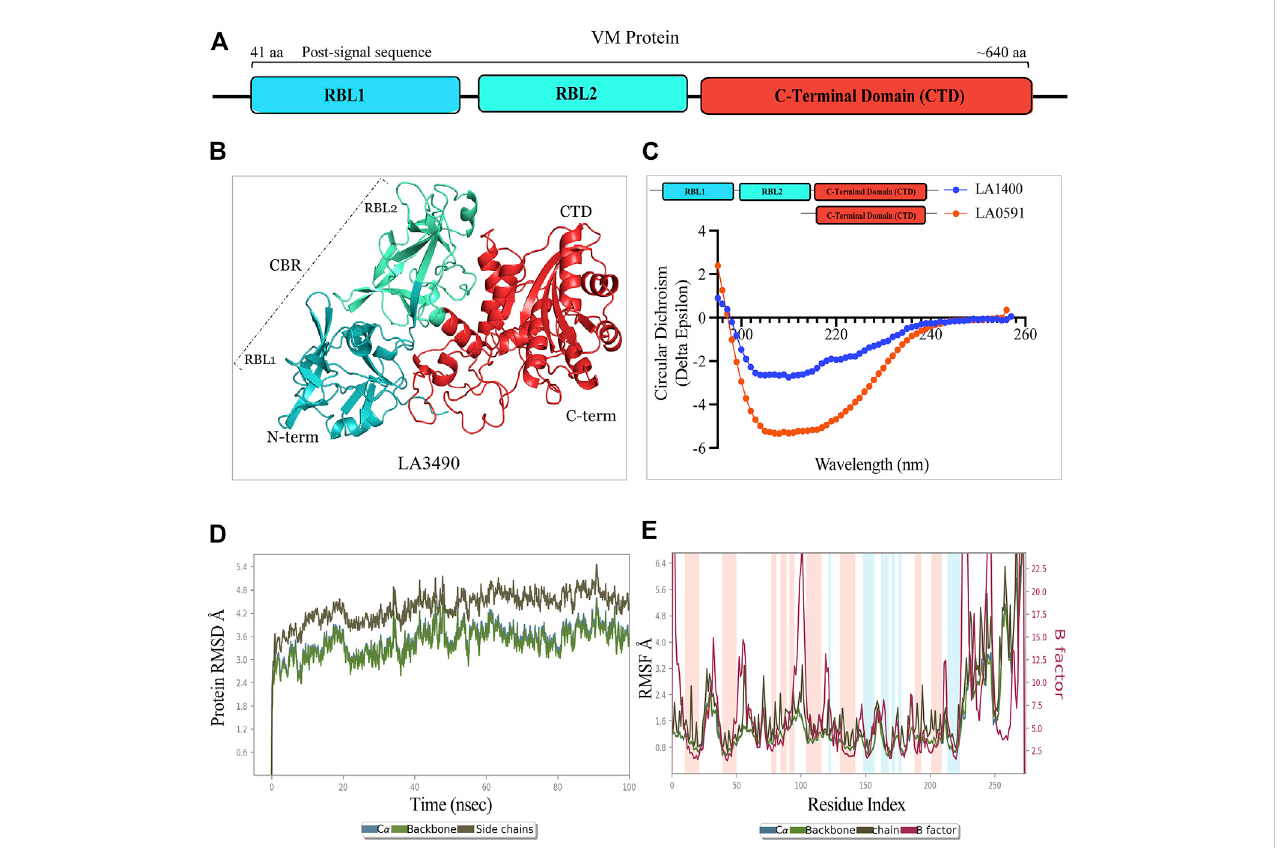
FIGURE 1 Schematic diagram, structure, and validation of VM protein by CD-spectroscopy and molecular dynamics simulation. (A) VM protein comprised N-terminal ricin binding domain RBL1 (41 aa-195 aa, teal color) and RBL2 (196 aa-335 aa, cyan-green color) as a carbohydrate binding domain (CBD) and the functional C-terminal domain (CTD: 368 aa-639aa, vermilion color). The domains showing amino acid numbers is with respect to LA3490. (B) AlphaFold derived 3D-stucture showing multi-globular domain of LA3490 VM protein (C) CD-spectra of soluble recombinant full-length LA1400 and natural variantLA0591(313aa)lacking RBLs(RBL1 andRBL2)showingthesecondary(helixandß-sheet) structurecontent. (D) Themolecular dynamicssimulationfor CTD of LA3490 shows stabilized RMSD of an average of 3.2 Å (E) The RMSF plot shown 0, 1 Å and fl uctuation was observed from 25 ns to 65